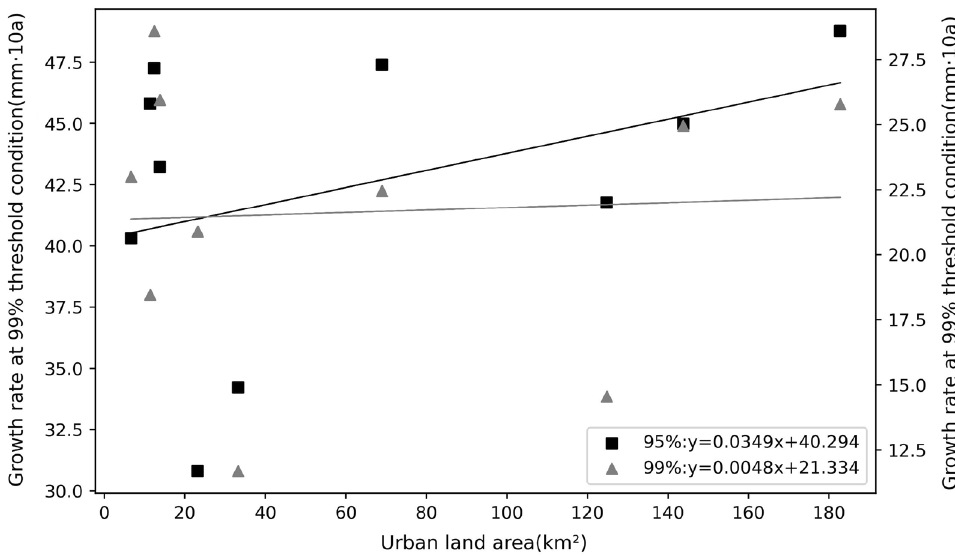
Figure 8. Average urbanization intensity versus the absolute rate of increase in extreme precipitation over 5 periods.